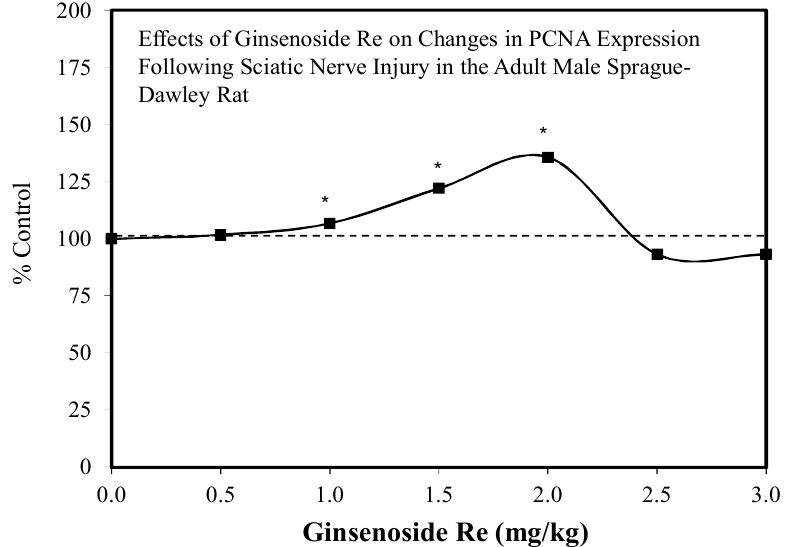
Figure 38. Effects of ginsenoside Re on changes in PCNA expression following sciatic nerve injury in the adult Male Sprague–Dawley rat (source: [120]). Each * represent statistical significance for a data point.